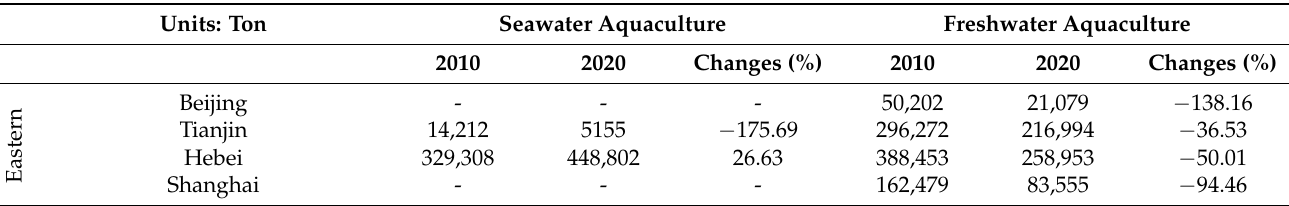
Table A1. Yield variation in Seawater Aquaculture and Freshwater Aquaculture in different Chinese regions. Source: Authors’ own calculations based on data from the China Fisheries Statistical Yearbook 2011 and China Fisheries Statistical Yearbook 2021